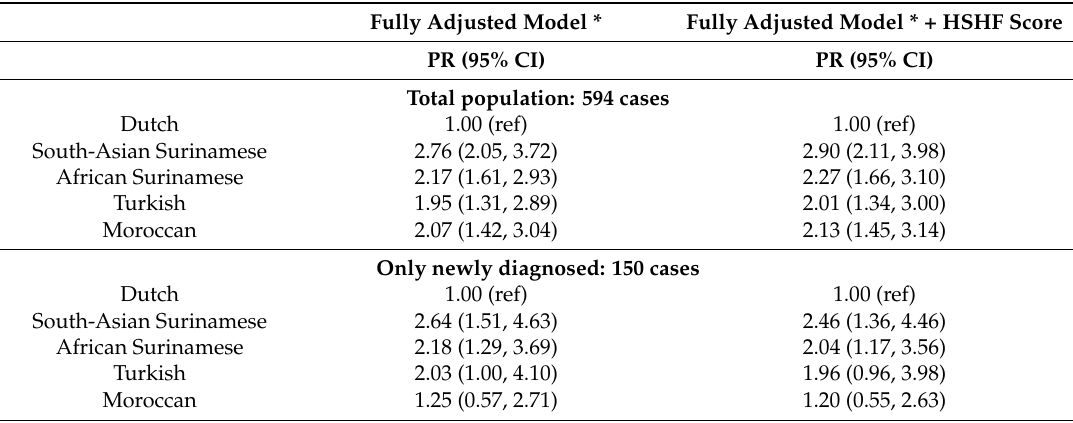
Table 5. Ethnic differences in T2D, adjusted for known risk factors and HSHF